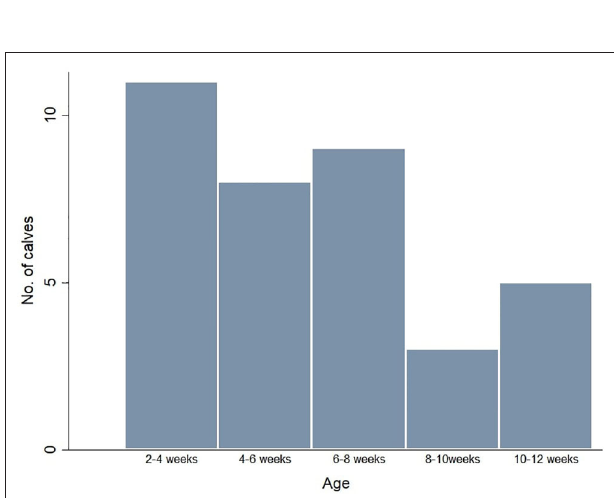
FIGURE 2 | Distribution of ages of calves included in the